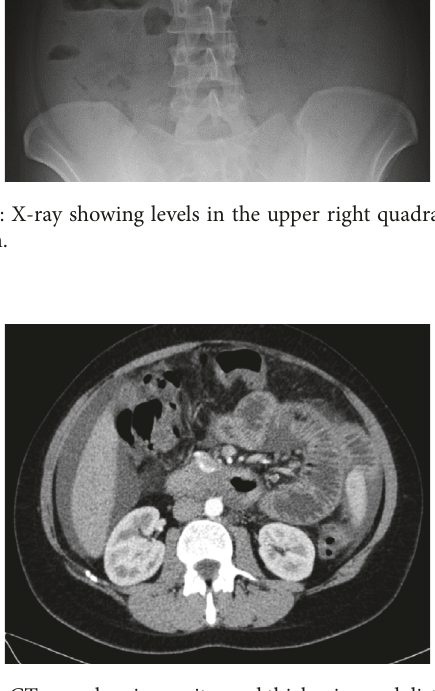
Figure 2: CT scan showing ascites and thickening and distension of small bowel